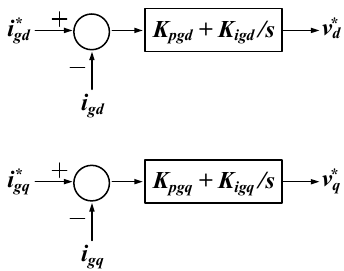
Figure 24. PI controller for grid current control.